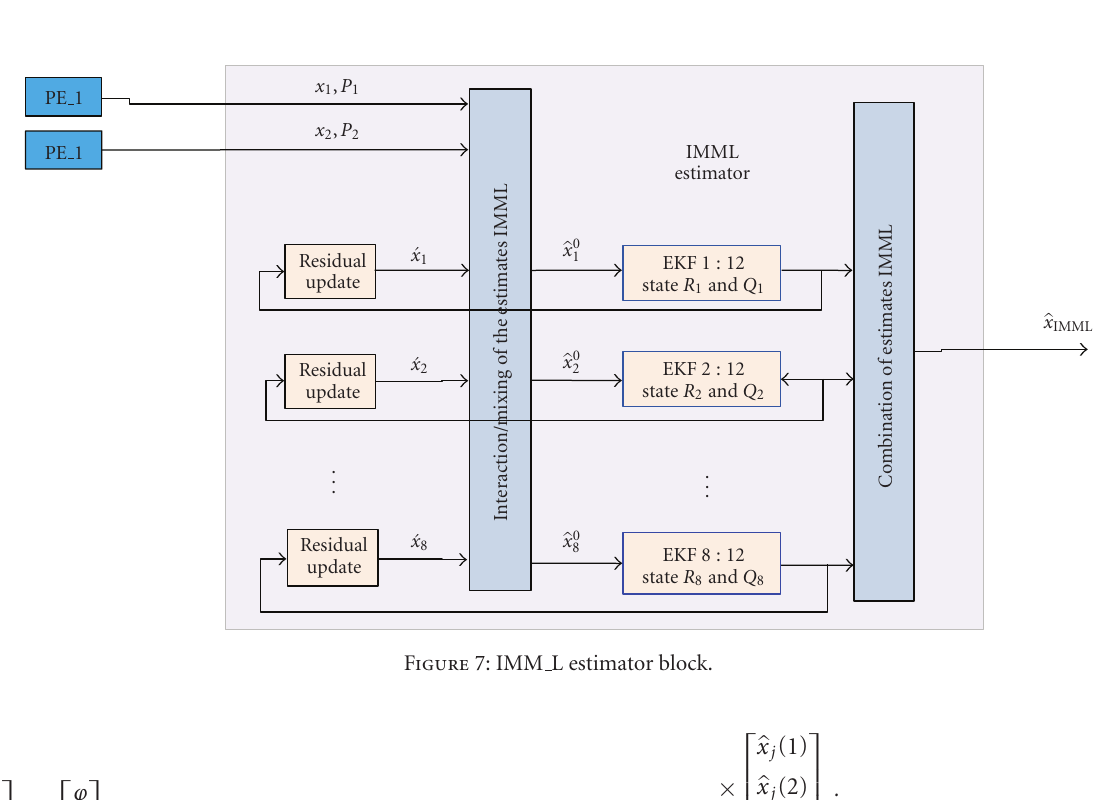
Figure 6: EIMMAE structure.